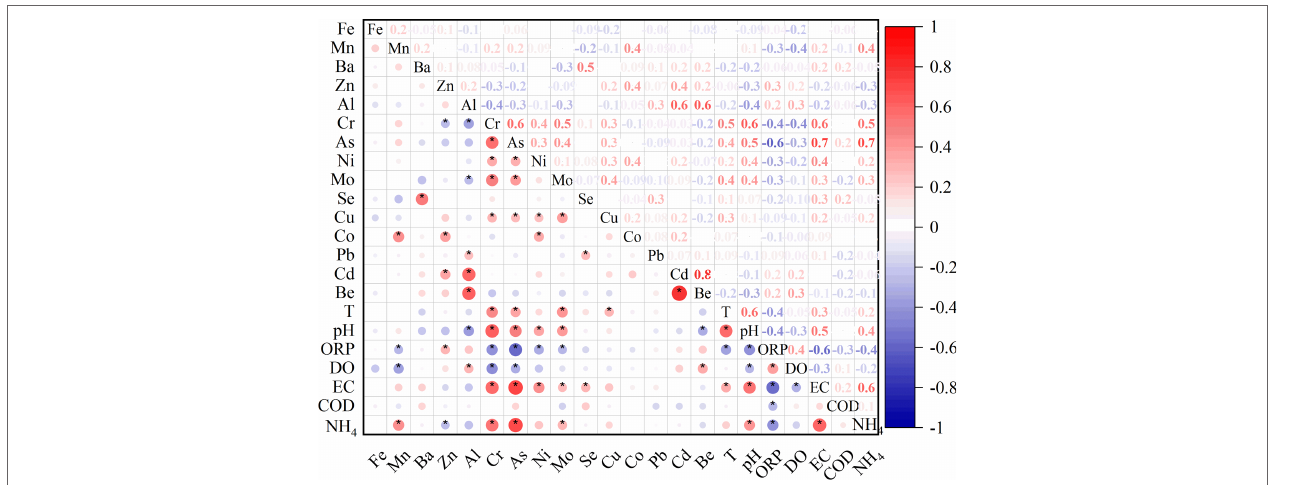
FIGURE 6 | Matrixes of Person correlations between trace metals and other field parameters in this study area. Red and blue dots inside the squares correspond to the negative and positive correlations with p <0.05, respectively. Light-colored small dots represent low correlations, while darker-colored large dots correspond to higher correlations. Missing dots inside the squares indicate an insignificant relationship between the pairwise